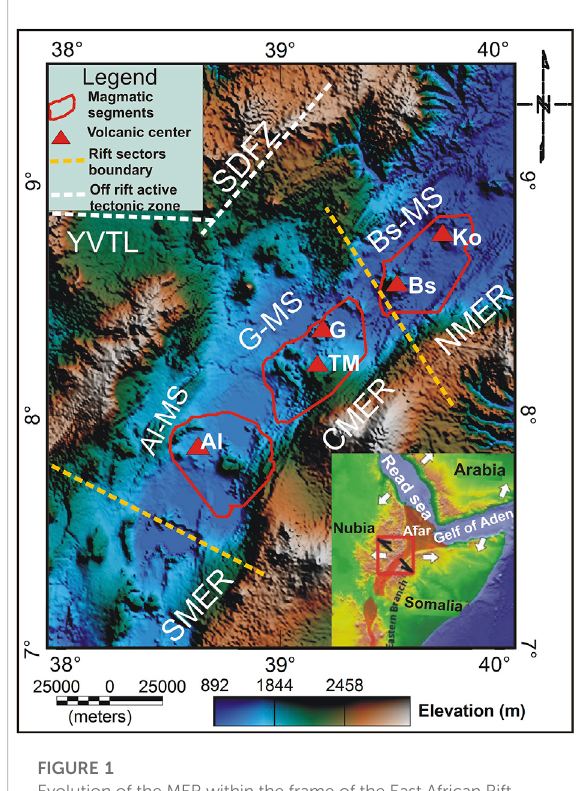
FIGURE 1 Evolution of the MER within the frame of the East African Rift System (right bottom panel): a change in Nubia-Somalia kinematics from orthogonal (white arrows) to oblique extension (blackarrows)(Boccalettietal.,1998;Wolfendenetal.,2004). The main map shows the en echelon arrangements of magmatic segments in the MER (Ebinger and Casey, 2001; Kurz et al., 2007): the rectangle in the red line is the MER (the study area) and abbreviations: SMER, Southern MER; CMER, Central MER; NMER, Northern MER; MS, magmatic segment; Al-MS, Aluto magmatic segments;G-magmaticsegments,Gedemsamagmaticsegments; Bs-MS, Boseti magmatic